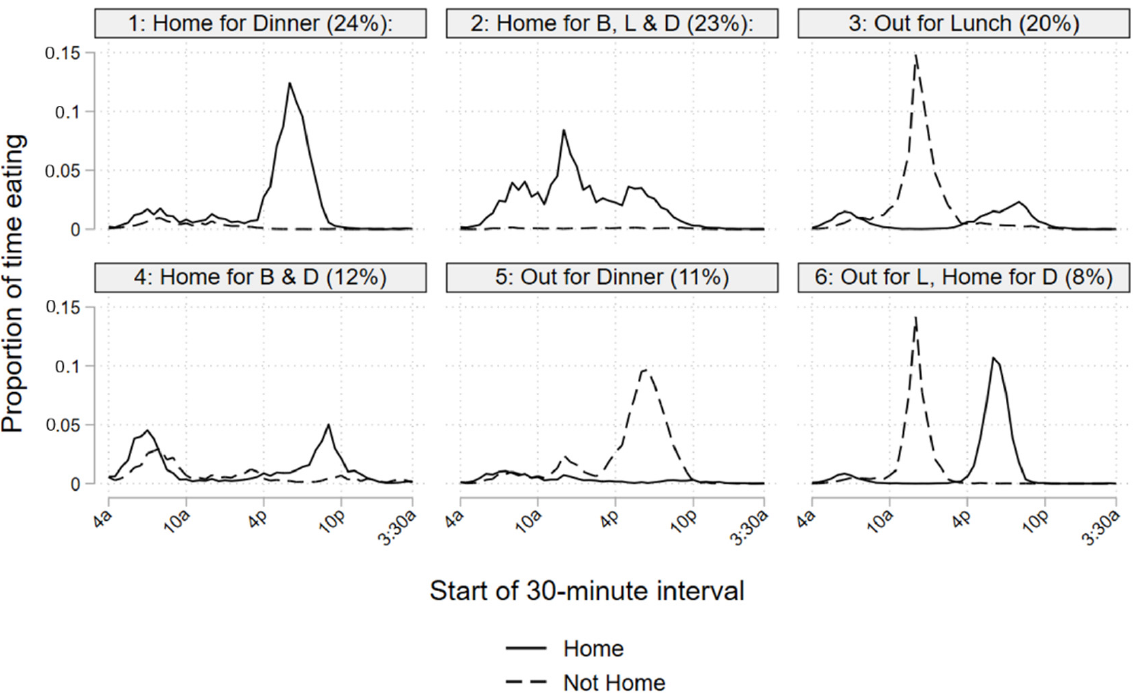
Table 3. Descriptive Statistics for Sample and by Cluster ( n = 15,872; survey weights applied).